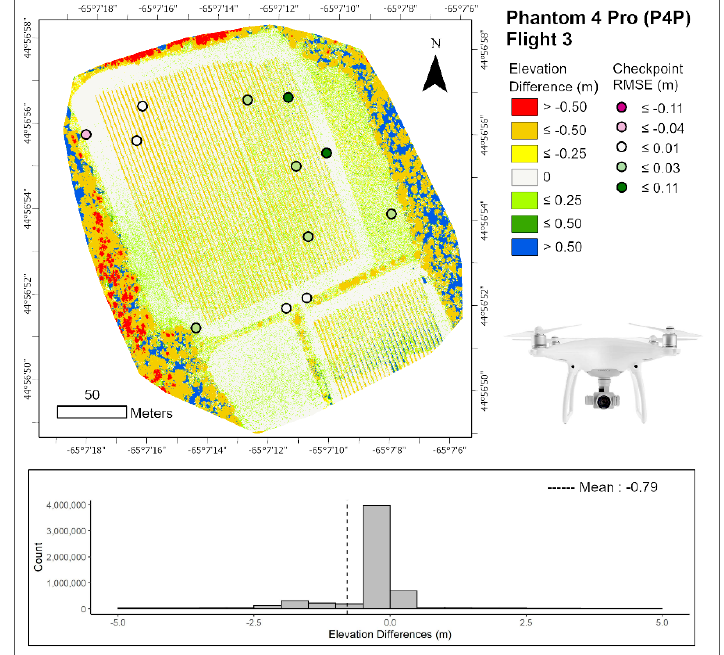
Figure 7. DSM of Difference (DoD) between the Phantom 4 Pro (P4P) (flight 3) and the LiDAR DSM. Figure 7. DSM of Di ff erence (DoD) between the Phantom 4 Pro (P4P) (flight 3) and the LiDAR DSM. The dashed line represents the mean error of − 0.79 m. The dashed line represents the mean error of − 0.79